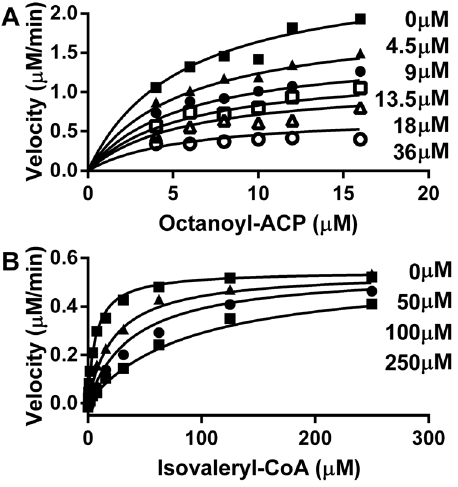
Figure 6. Inhibition of acyl-HSL synthases by substrate analogs. The best-fit models of inhibition are graphed. The m M concentration of inhibitor for each experiment is shown next to the curve. A) Substrate-velocity curves of mixed inhibition of 0.4 m M BmaI1 by octyl-ACP. B) Substrate-velocity curves of competitive inhibition of 0.5 m M BjaI with varying